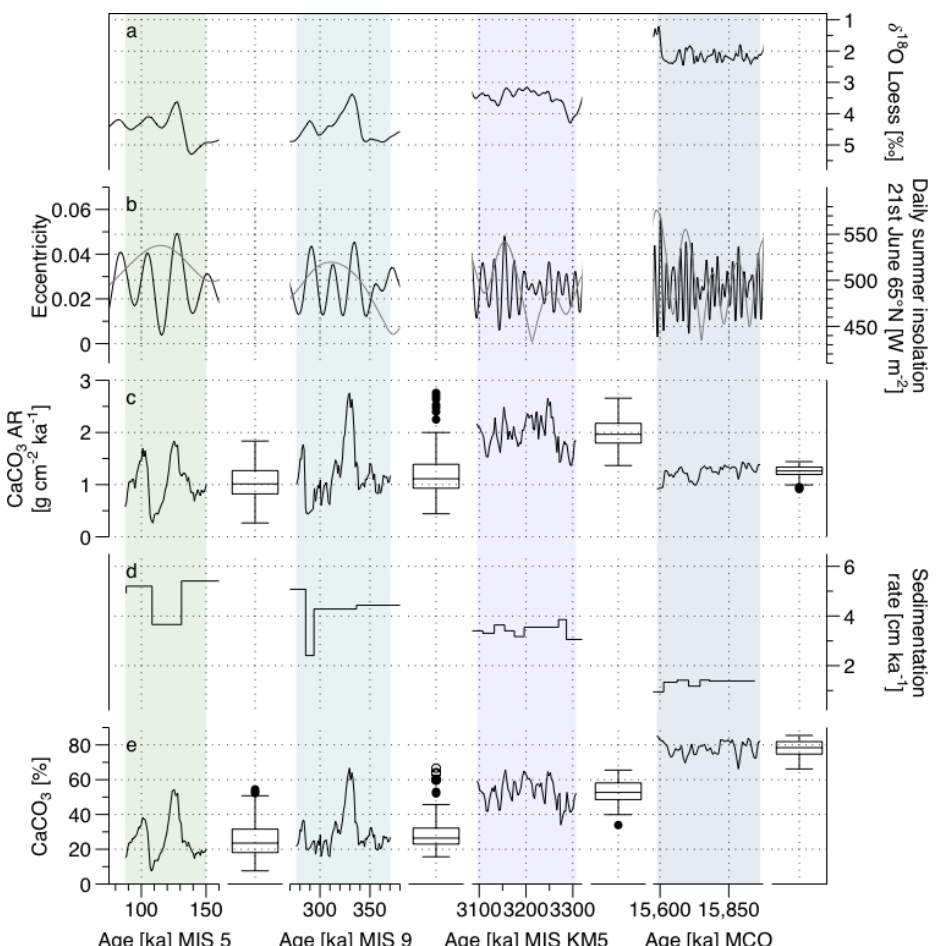
Figure 8. (a) Quaternary and Pliocene benthic stable oxygen records from Site 927 and a global stack for the Miocene (Bickert et al., 2004; Westerhold et al., 2020). (b) Orbital parameters: eccentricity and daily summer insolation for 21 June at 65 ◦ N (Laskar et al., 2004). (c) CaCO 3 AR and boxplot for each interval. (d) SR and (e) CaCO 3 % in the dried bulk sediment and a boxplot for each